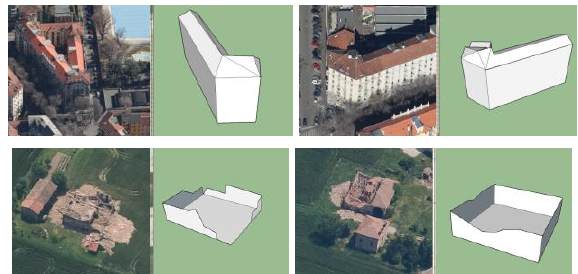
Figure 8. Examples of initial 3D building block reconstruction using the monoplotting tool. In case of damaged building, only the survived structures are digitized and